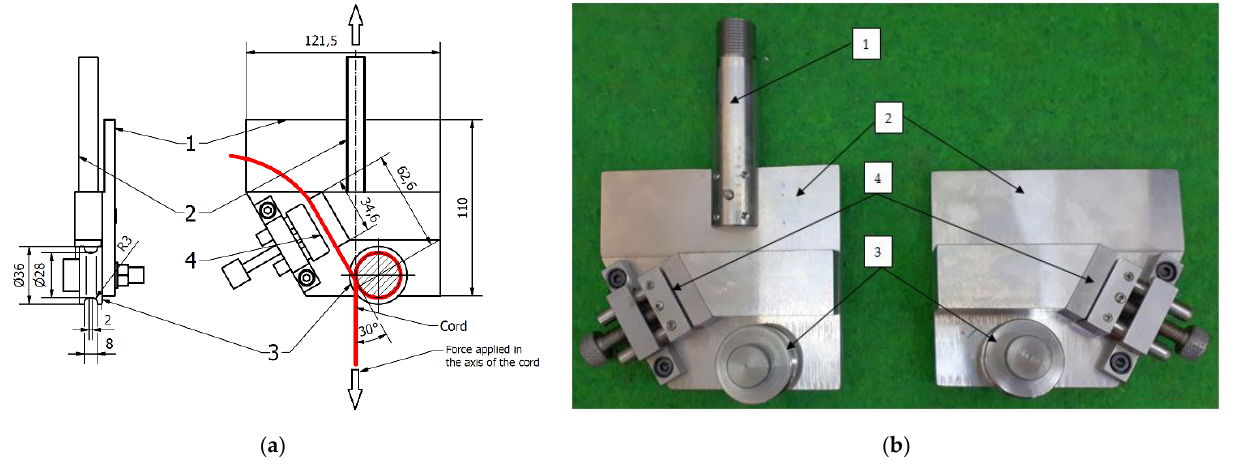
Figure 3. Cord grips: ( a ) technical drawing with cord and applied force visualization and ( b ) real photo; 1 — machine jaws with flat inserts; 2 — threaded mount; 3 — rollers; and 4 — clamps of cord grips.